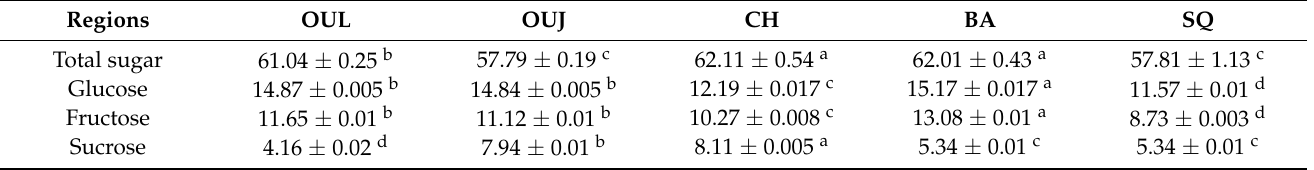
Table 5. Total sugar content (gEG/100 g) and soluble sugars (g/100 g DW) of A. unedo L. fruits samples over surveyed